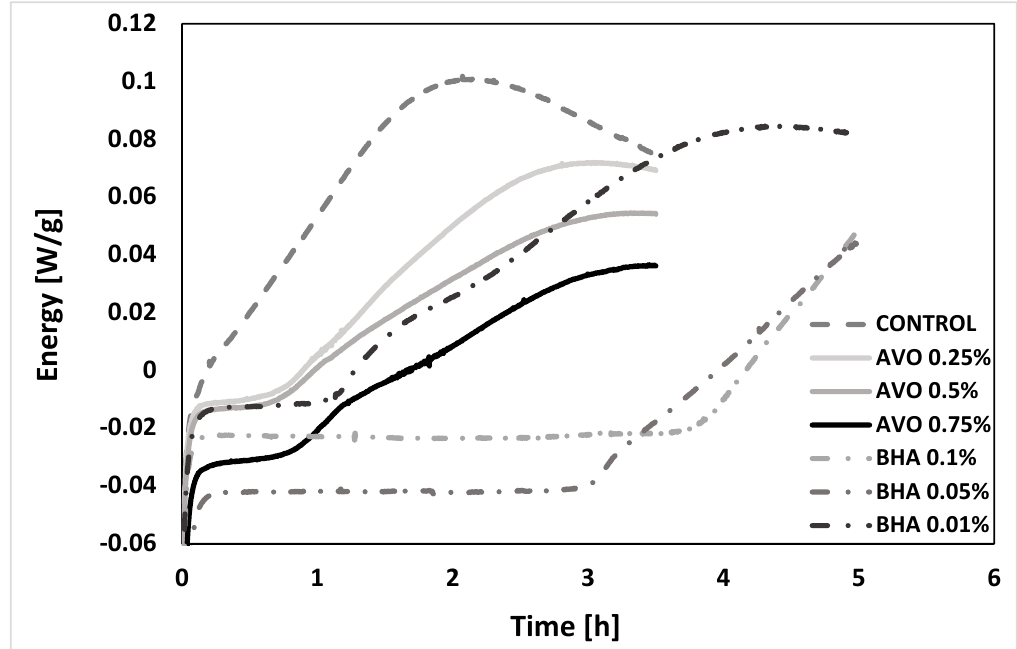
Figure 4. Isothermal analysis to determinate OIT value for sunflower oil fatty acid mixture.